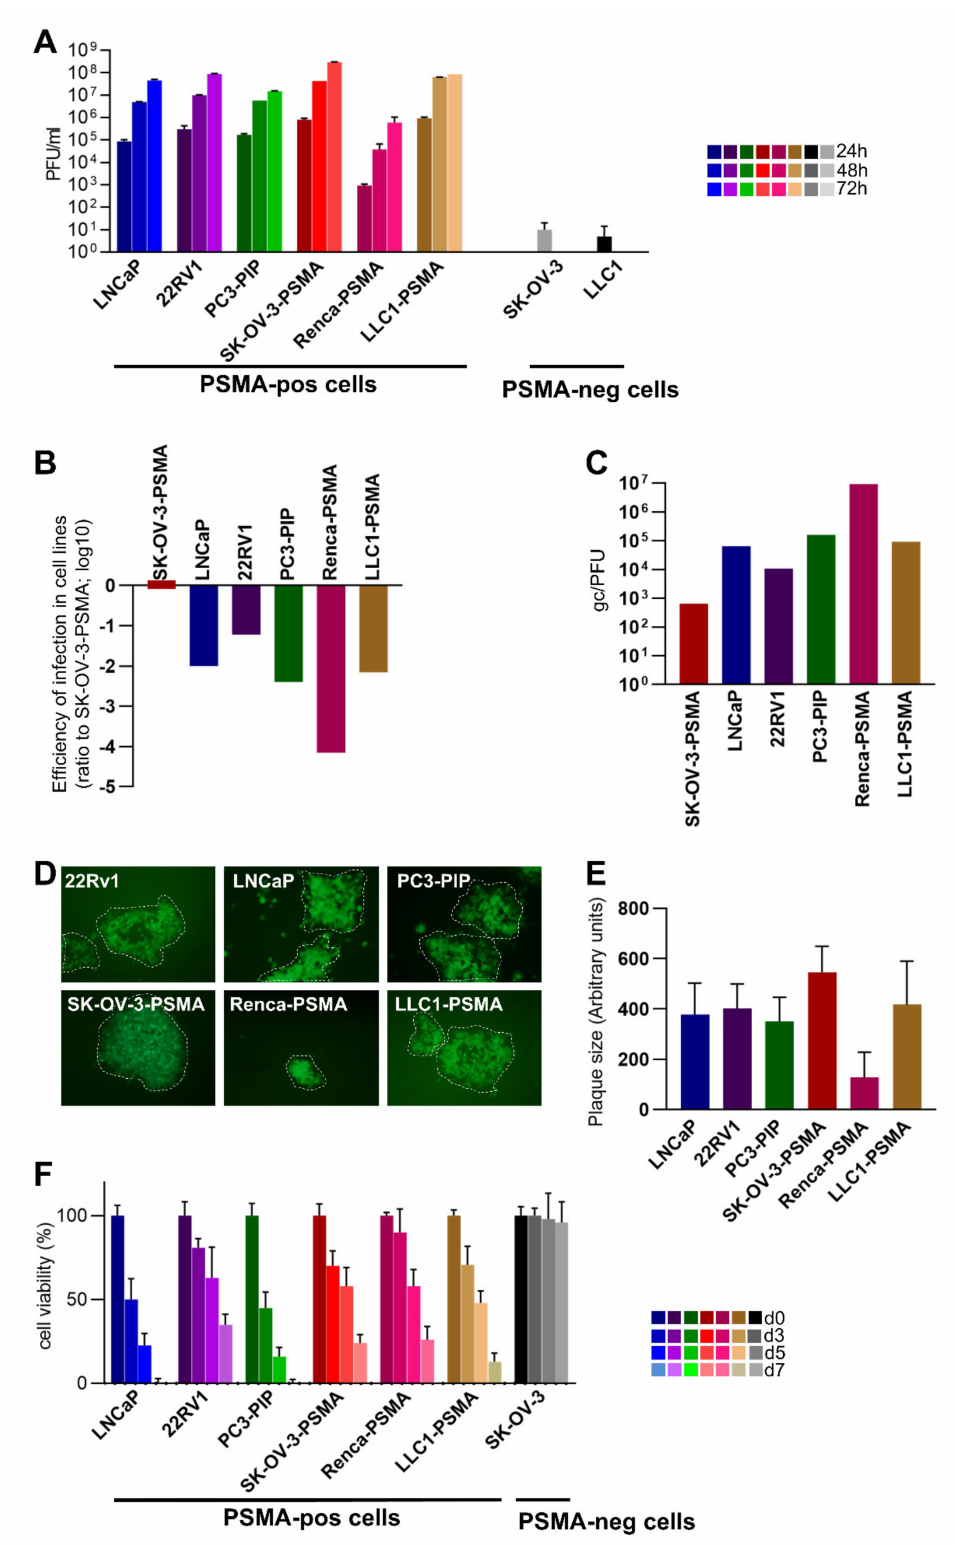
Figure 2. Infectivity, cell-to-cell spread, and cytotoxicity caused by R-405 in different PSMA-positive cell lines. ( A ) Time course of R-405 replication in the indicated cells lines. Infected cells were harvested at 24, 48, and 72 h after infection